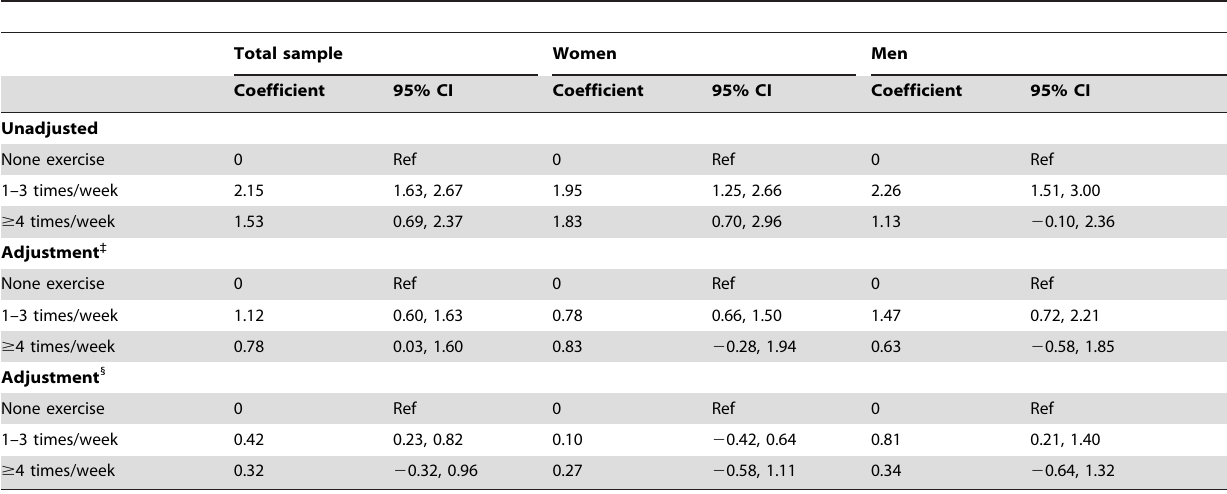
Table 2. Prospective associations between exercise* reported in the HUNT 3 study and subsequent reporting of pain { measured every third month during a 12 month follow up period of the HUNT pain study.